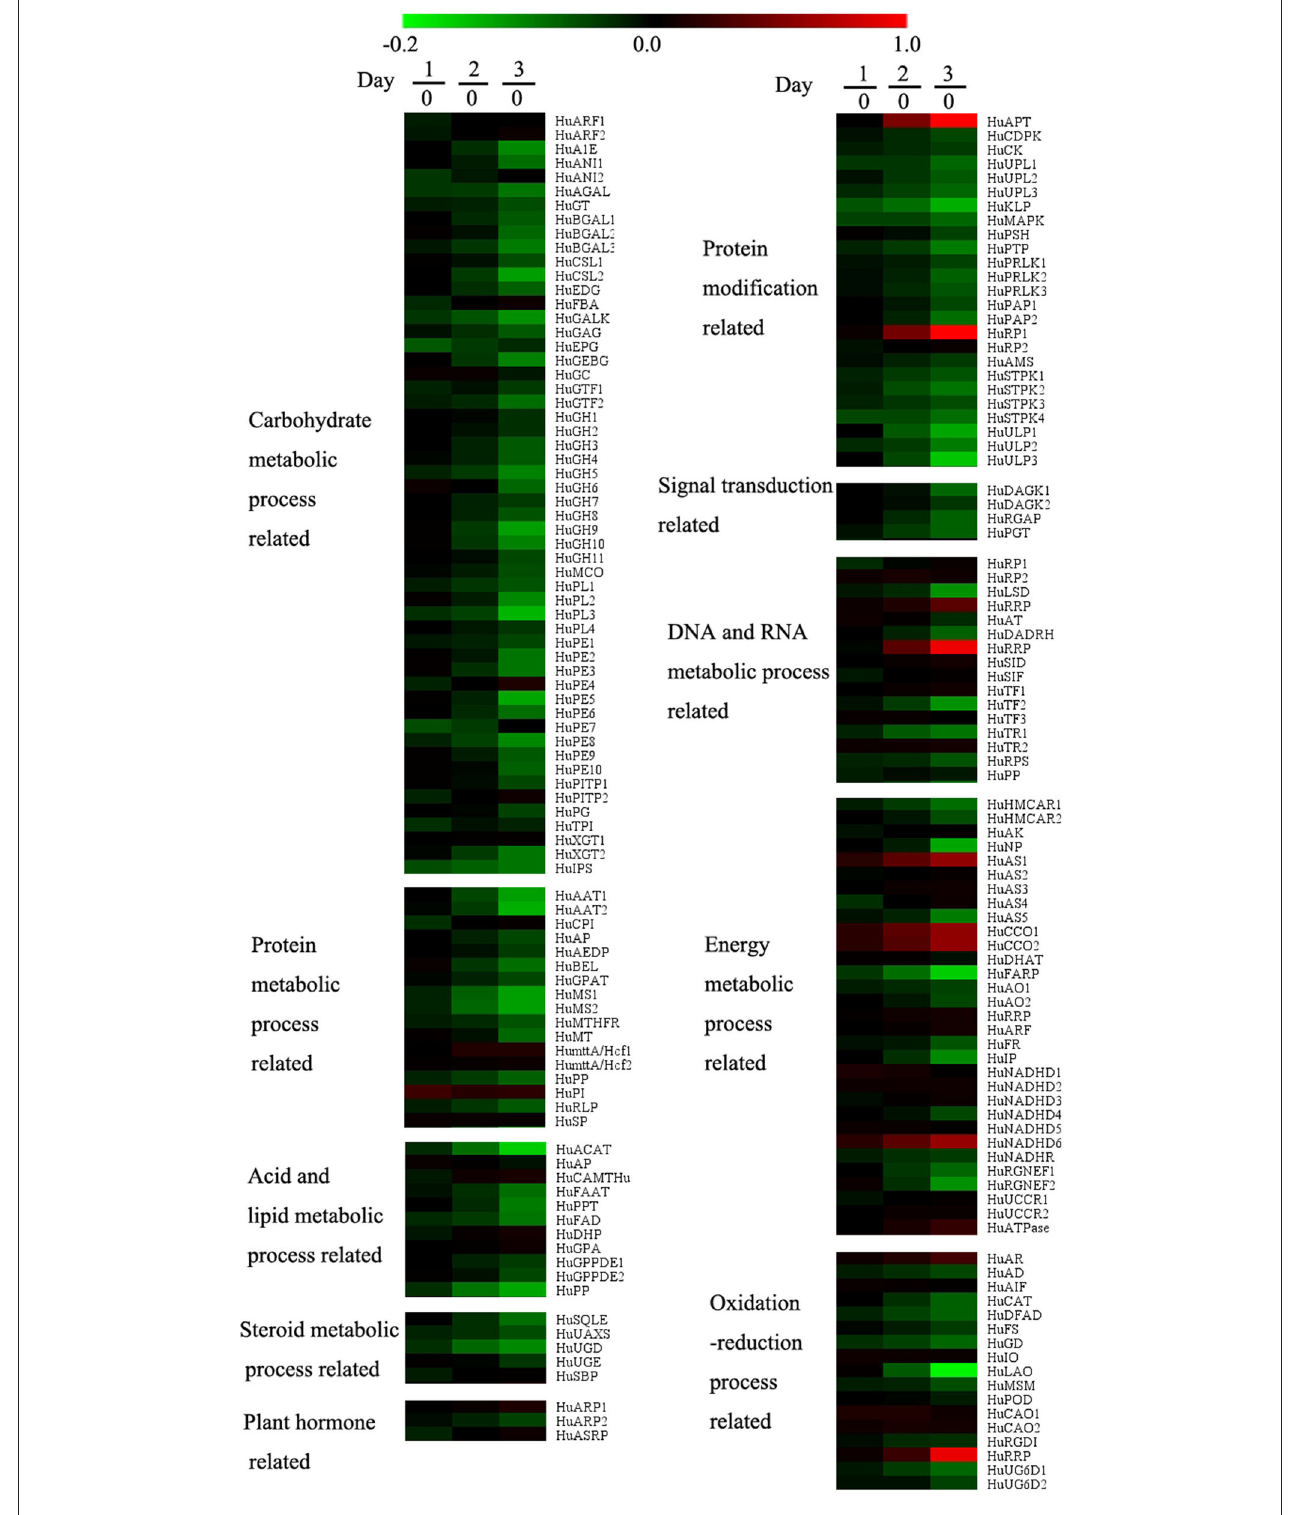
FIGURE 5 | Effect of low temperature on gene expressions of pollen in pitaya. Each data point represents a mean ( n = 3). Samples on days 0, 1, 2, and 3 were used for the transcriptomics experiment and 174 genes met the conditions (VIP > 1 and p < 0.05) as differentially expressed genes.